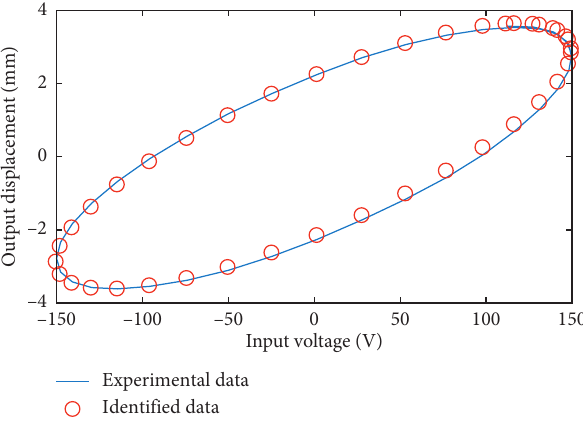
Figure 4: Hysteresis loop of the experiment and